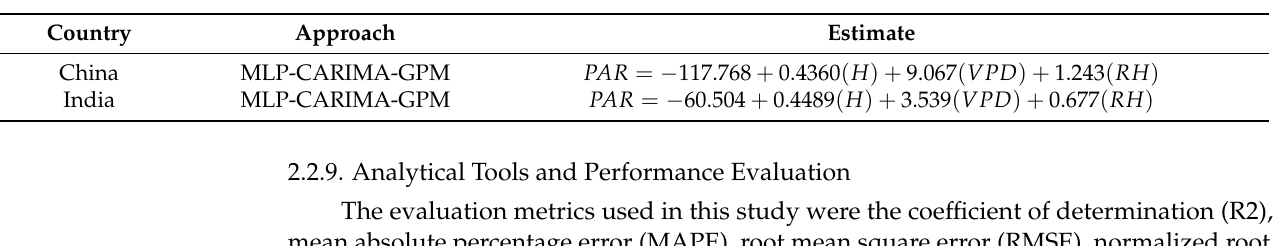
Table 6. Fitted best performing models for predicting PAR productivity hybrid models for China and India.